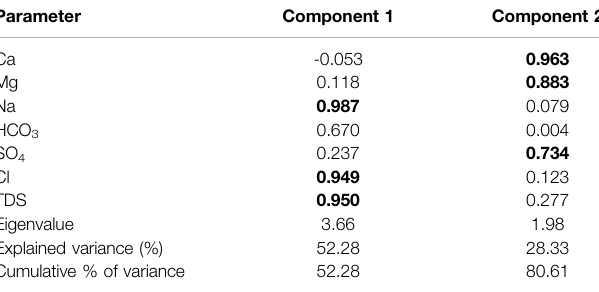
TABLE 3 | Principal component loadings and explained variance for two